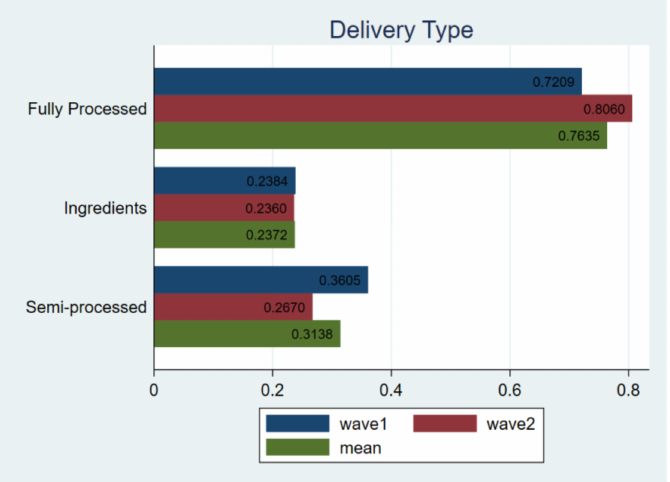
Figure 8. Comparing delivery types. Notes: t -test for H 0 : equal variance assumed: t value = − 0.7620, Pr (|T| > |t|) = 0.4462; wave1 vs. wave2.